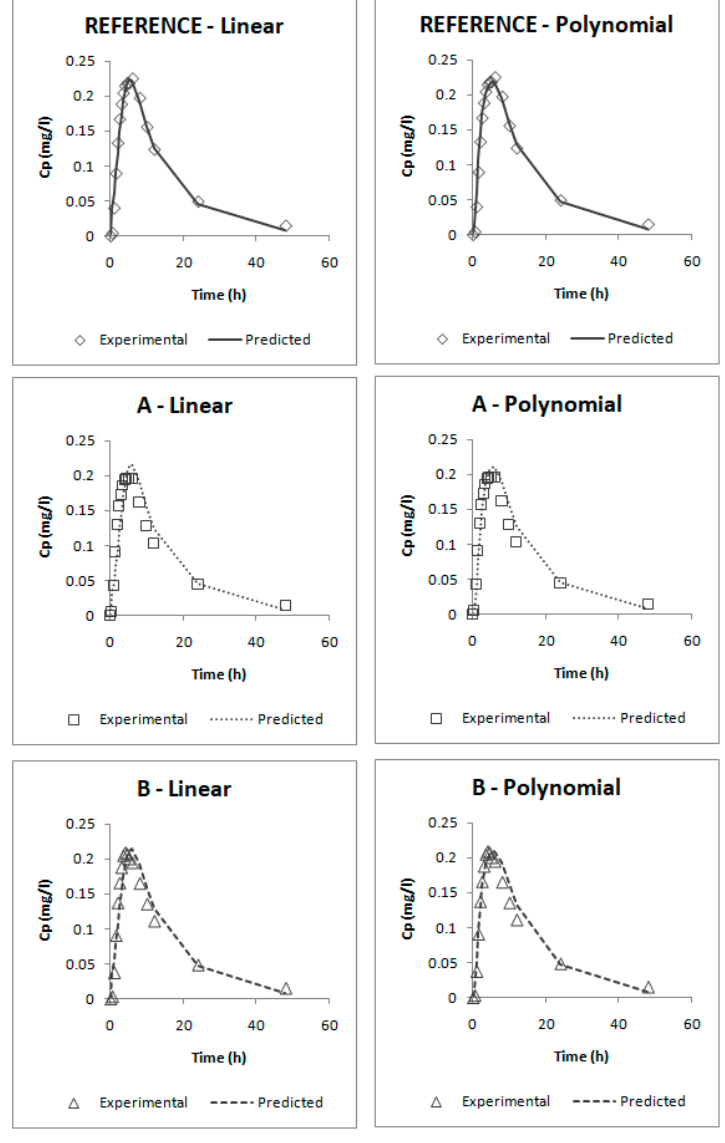
Figure 11. Experimental and predicted candesartan plasma profiles for the three studied formulations using the linear two-step IVIVC and the polynomial two-step IVIVC. C p = plasma concentration.